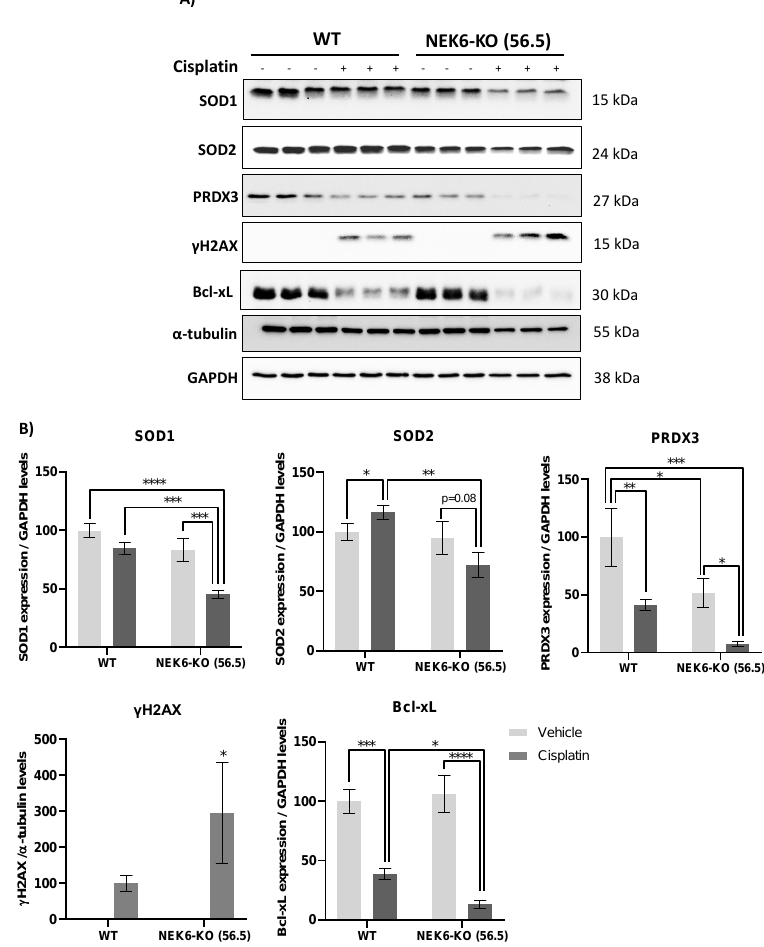
Figure 6. NEK6 depletion sensitizes DU-145 to cisplatin through the impairment of antioxidant defenses and increase of DNA damage. ( A ) WT and NEK6-KO (56.5) cells were treated with cisplatin 30 µ M for 24 h. SOD1, SOD2, PRDX3, Bcl-xL expression, and γ H2AX were evaluated by Western blotting. ( B ) Western blotting quantification was performed using ImageJ. * p < 0.05, ** p < 0.01, *** p < 0.001, and **** p <